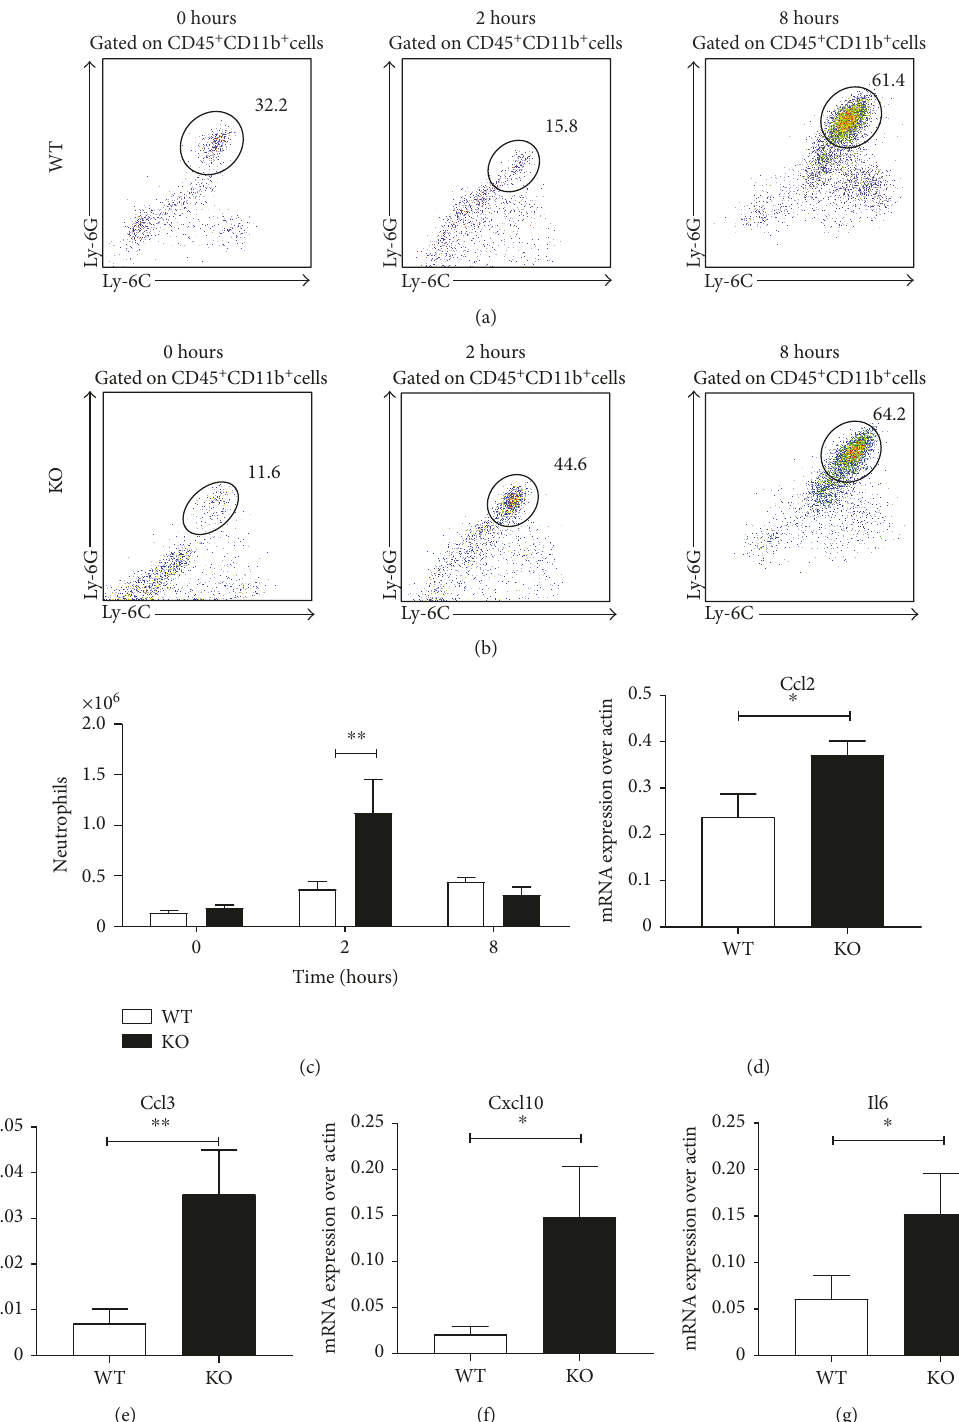
Figure 6: CB knockout mice have increased neutrophils in the spleen at 2 hours following LPS challenge. Male C57BL/6J and CB 2 mice (8 – 10 weeks old) were administered i.p. with 1mg/kg LPS for 8 hours and neutrophil numbers in the spleen were assessed for 8 hours. Spleen homogenates were stained for neutrophils (CD45 + CD11b + Ly-6G hi Ly-6C + ) by fl ow cytometry. Representative dot plot graphs from one C57BL/6J (a) and one CB knockout (b) mouse gated on CD45 + CD11b + cells are shown for the full time course. Pooled data 2